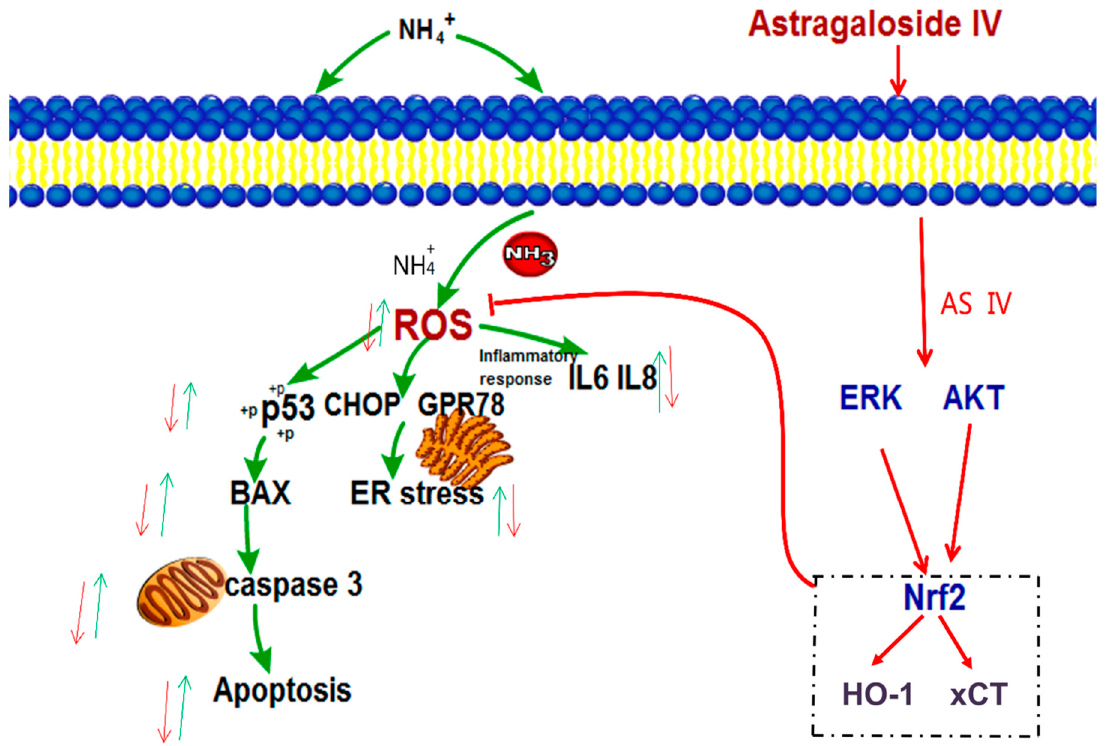
Figure 9. A putative mechanism of astragaloside IV alleviating ammonia-induced apoptosis and oxidative stress in bovine mammary epithelial cells. The green arrows indicate the effects of ammonia on MAC-T cells, and the red arrows indicate the effects of astragaloside IV on ammonia-induced apoptosis and oxidative stress in MAC-T cells.